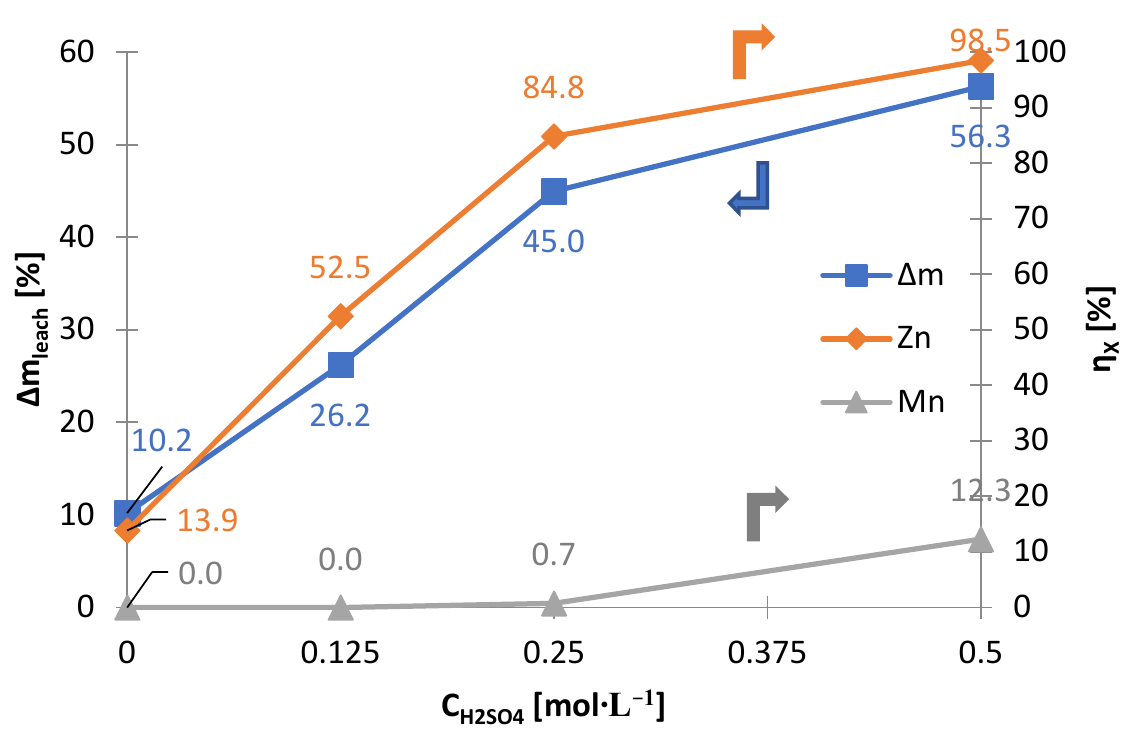
Figure 5. Effects of sulfuric acid concentration (C H2SO4 ) on mass loss of solid phase ( ∆ m leach ) and leaching yields ( η X ) of zinc and manganese as a result of selective leaching of black mass.